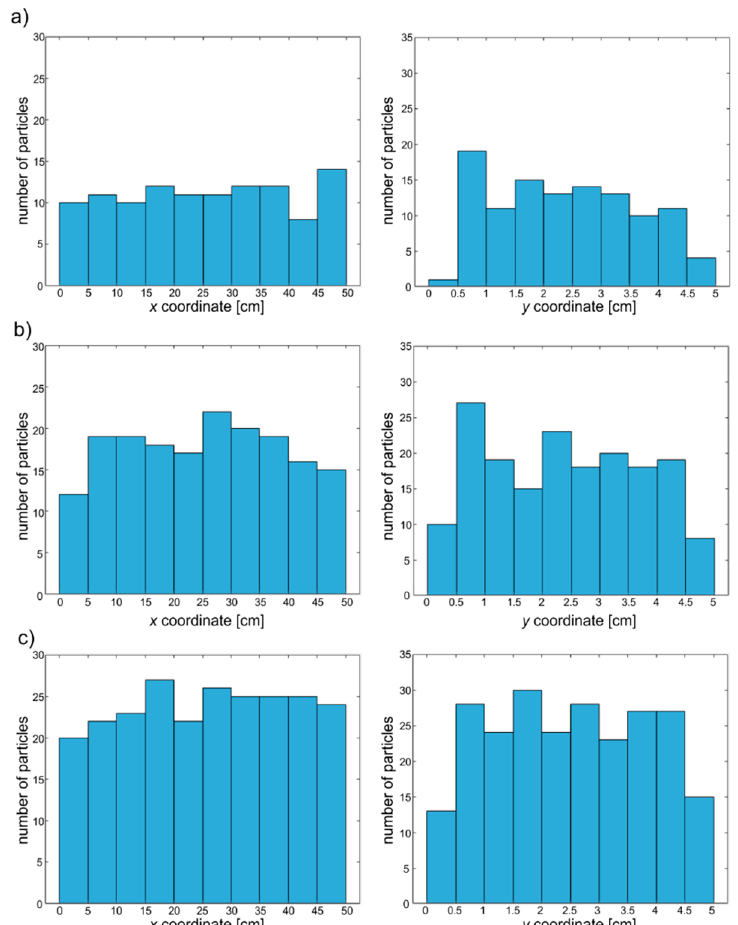
Figure 7. Histograms of the special distribution of the generated particles for model ( a ) A1, ( b ) A2, and ( c ) A3.